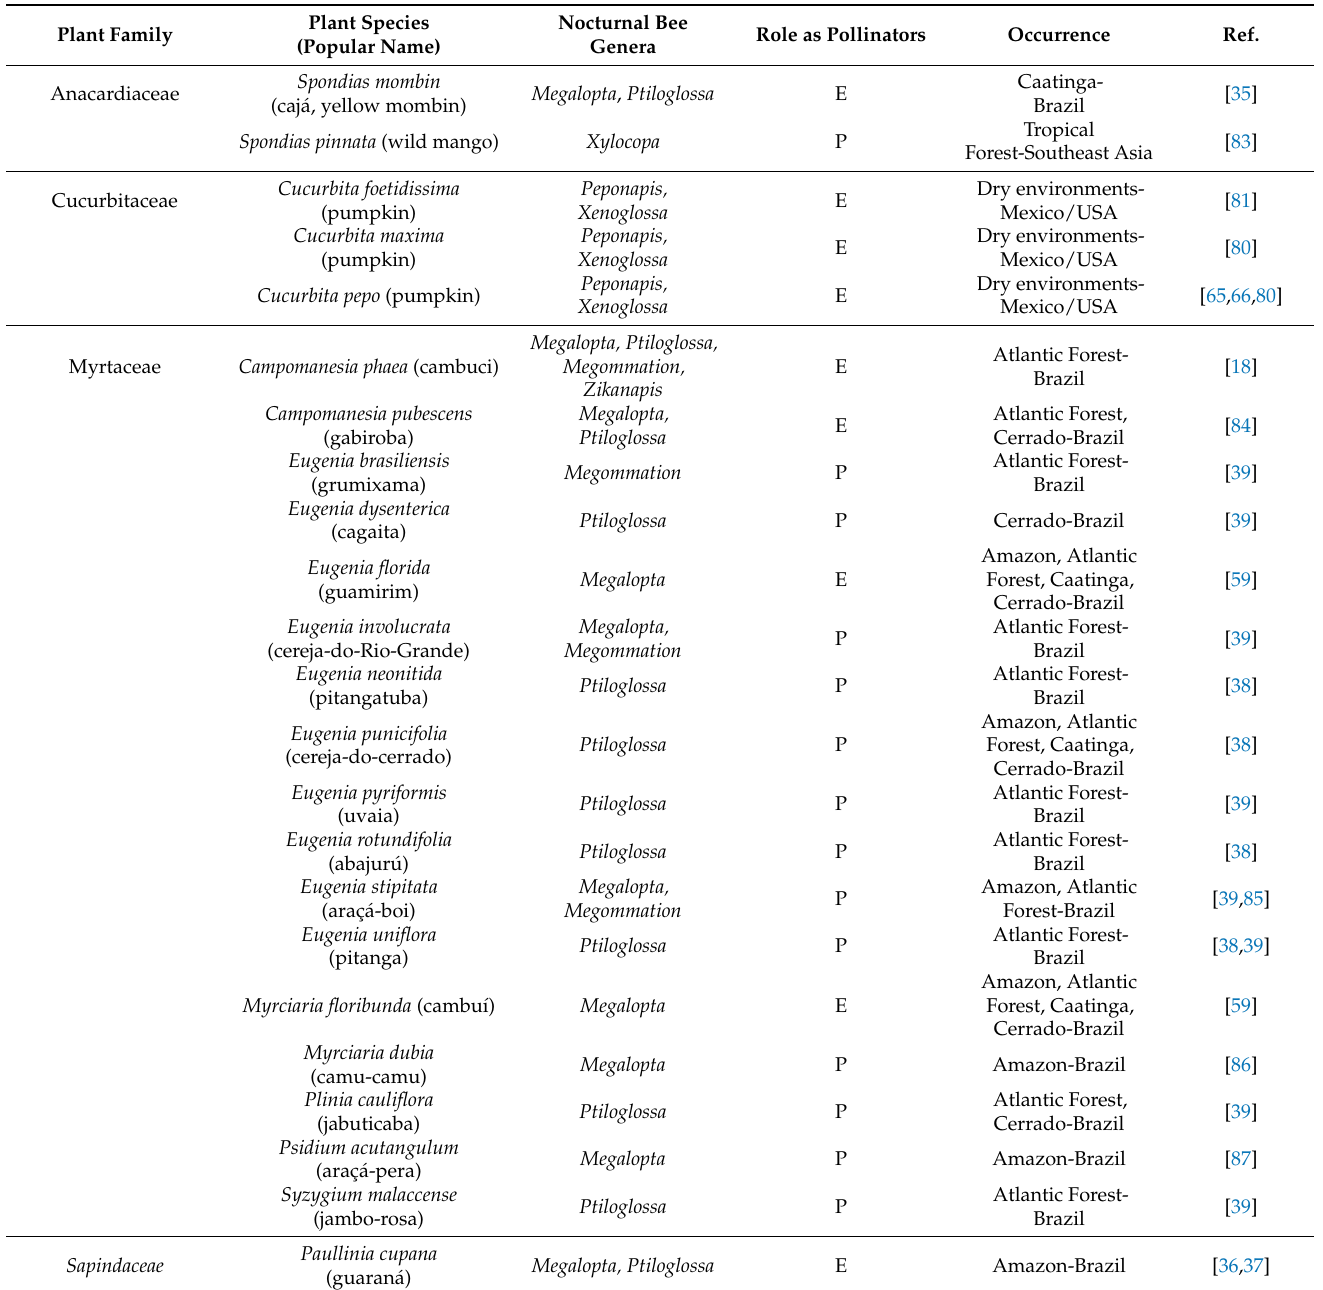
Table 1. List of crop plant families and species known to be pollinated (E = effective, P = potential pollination) by nocturnal bees; nocturnal bee genera that visit them; geographical occurrence; references